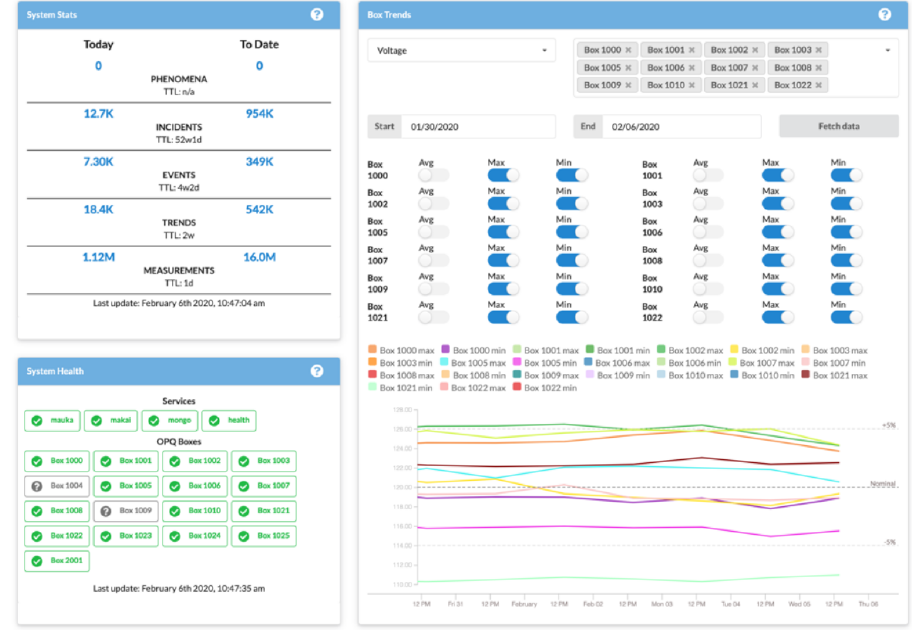
Figure 6. OPQ View: home